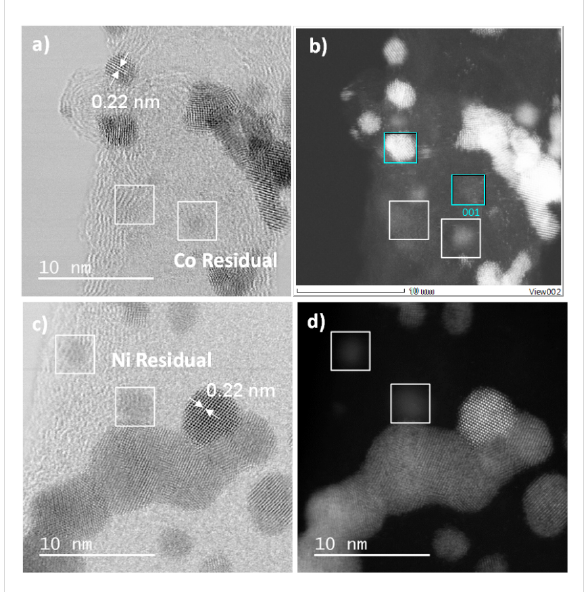
Figure 6: HRTEM images of a) Co/N-CNT and c) Ni/N-CNT HT ; and STEM-HAADF images of b) Co/N-CNT and d) Ni/N-CNT HT .